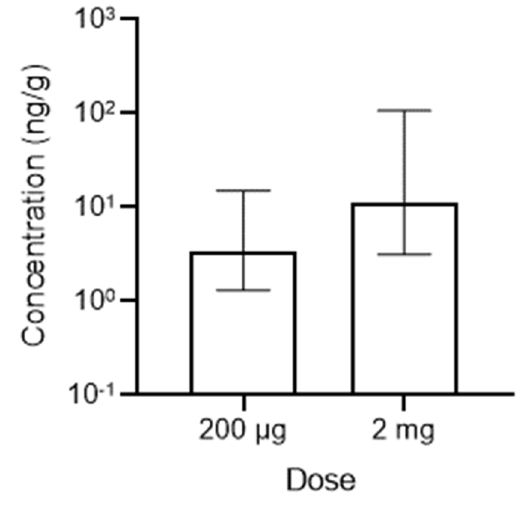
Figure 4. SPC microcrystals preserve nerve fibers and axons. A single unilateral subconjunctival injection of SPC micro- crystals (200 μ g in 5 μ L) or vehicle (Sham) was prior to laser induced hypertension ( n = 15–16). Optic nerves were evaluated for ( A ) number of nerve fibers and ( B ) percent reduction in nerve axons. Data shown as median ± IQR. * p < 0.05. Statistical analyses conducted by Wilcoxon rank sum test for two independent groups. ( C ) Retinal ganglion cell (RGC) loss was reduced with SPC microcrystals ( n = 7) compared to untreated animals ( n = 12), but not statistically significant ( p = 0.08) due to variability and loss of tissues during the staining process. Data shown as mean ± SD. Statistical analysis conducted by unpaired t-test.